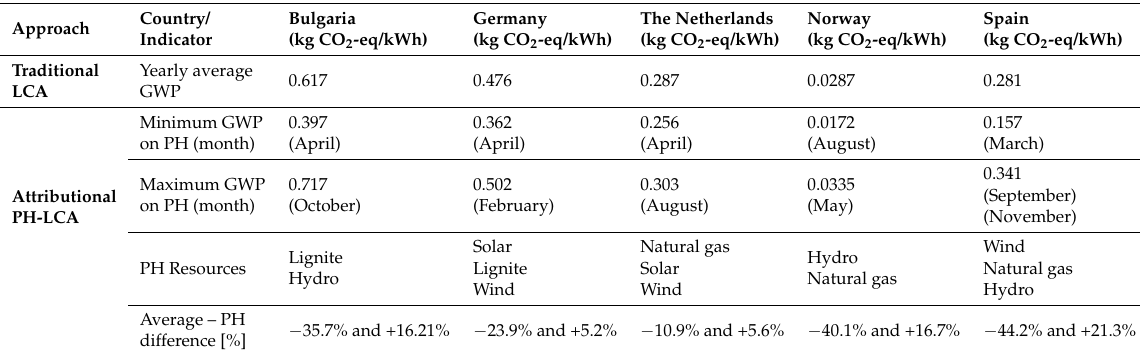
Table 9. Summary of results between LCA and peak-hourly life cycle assessment